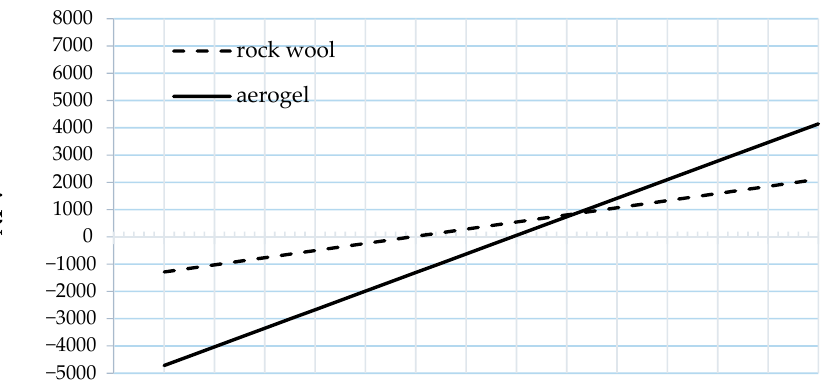
Figure 13. NPV as a function of tax incentives.